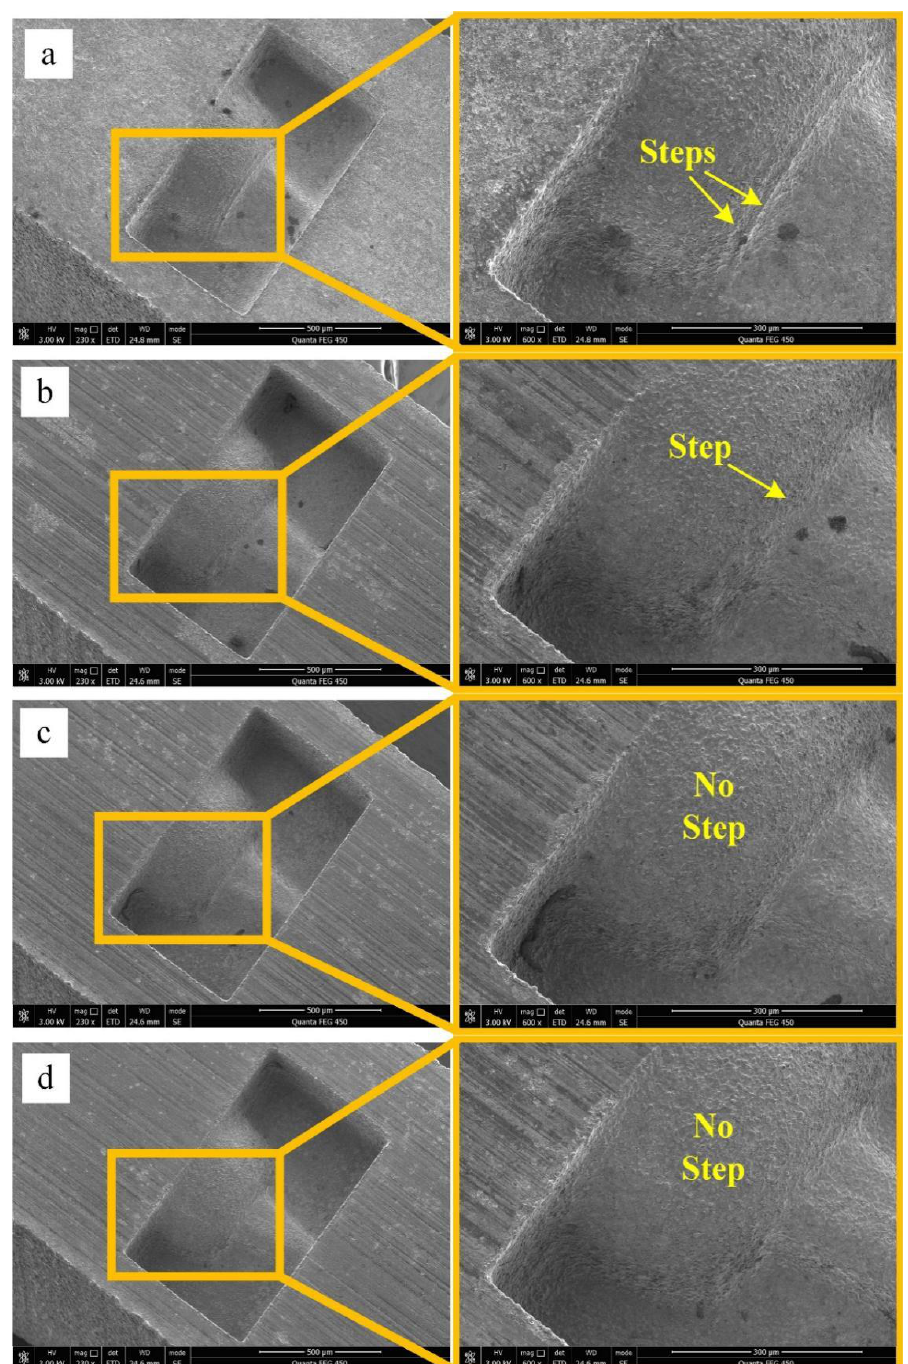
Figure 6. Micro-EDM results of FQ-microelectrodes with different number of F-microelectrodes: ( a ) 16; ( b ) 25; ( c ) 33; ( d ) 40.